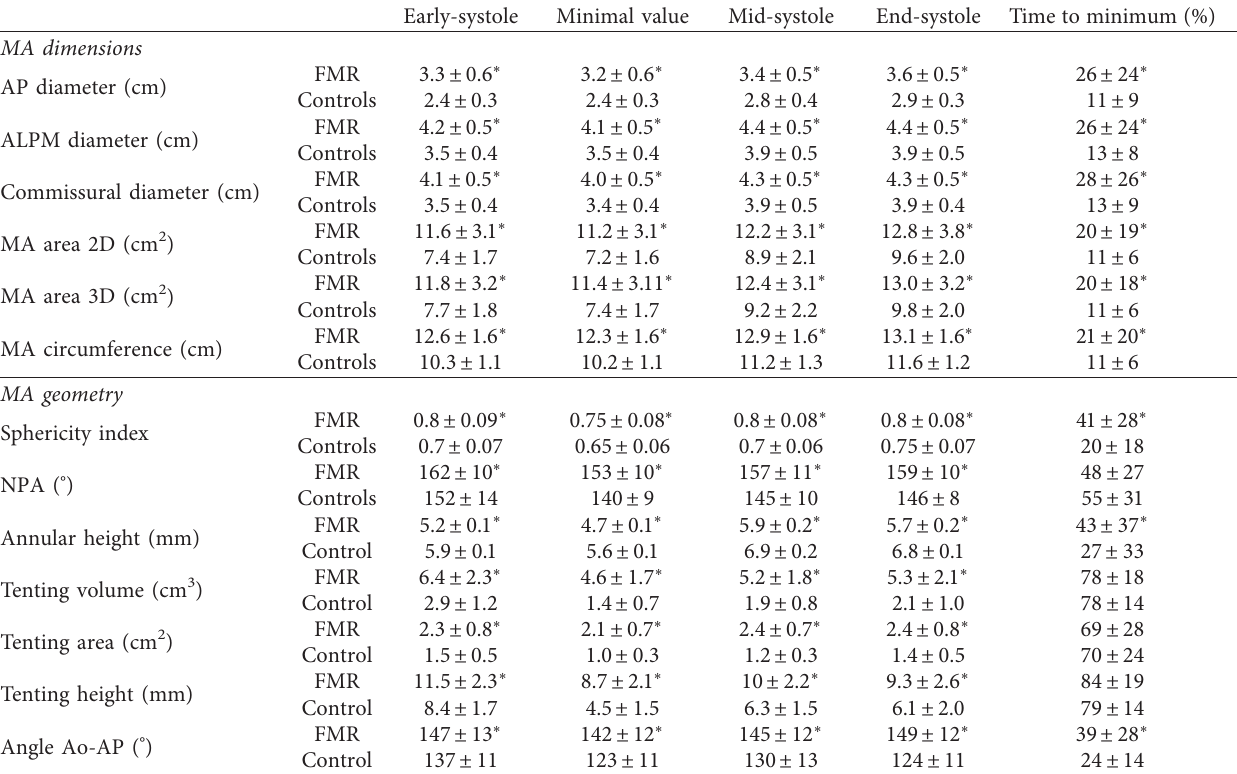
Table 3: The dynamic changes of the mitral annulus dimensions and geometry during the cardiac